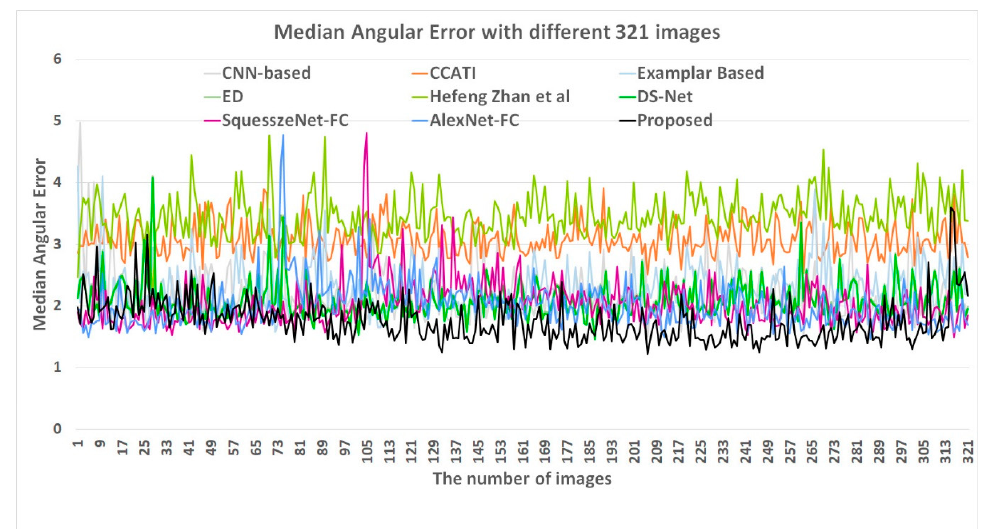
Figure 8. Comparison of the median angular errors of 321 different SFU-lab images.